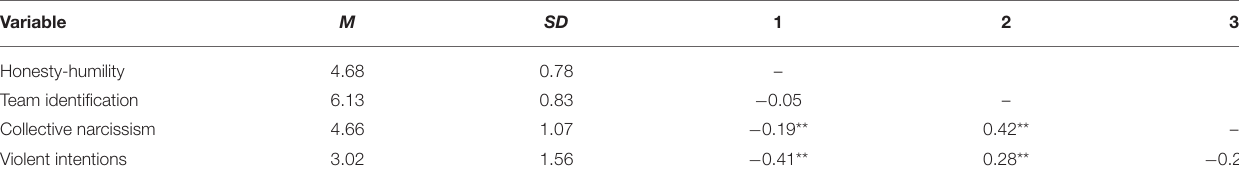
TABLE 1 | Descriptive statistics and correlations.